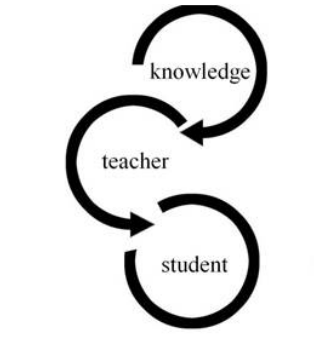
Figure 1. Vertical diagram ofknowledge-teacher-student relationship.